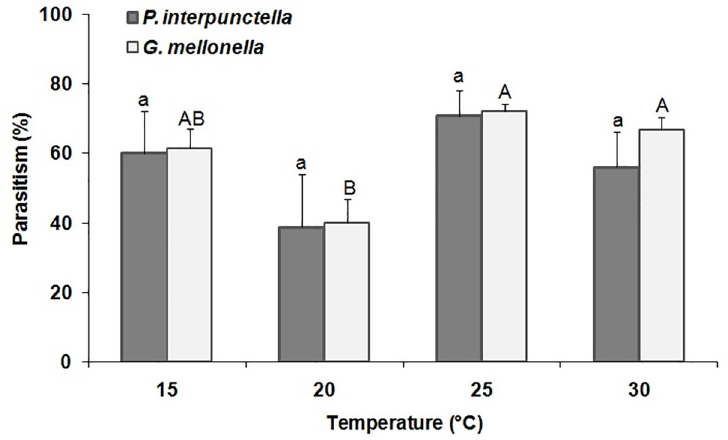
Fig 3. Mean percentage (% ± SE) of parasitism by T . evanescens in P . interpunctella and G . mellonella eggs on different temperatures (within each species, bars followed by the same letters are not significantly different; HSD test at 0.05; lowercase letters for P . interpunctella , uppercase letters for G . mellonella ). https://doi.org/10.1371/journal.pone.0253287.g003 species (Table 3). In most combinations, adult body length was higher in the individuals that were developed from G . mellonella , as compared with the respective figures of P . interpunctella . The body length varied significantly among temperatures (F = 171.68; df = 3,41; P = 0.001) and between the species (F = 1752.03; df = 1,41; P = 0.001). There were also significant varia- tions (F = 9.32; df = 3,41; P = 0.001)in the interaction of species � temperature for the adult body length. Finally, the highest mortality levels were recorded in T . evanescens reared at 20˚C for either host species, as indicated by the higher k -values (Table 3).